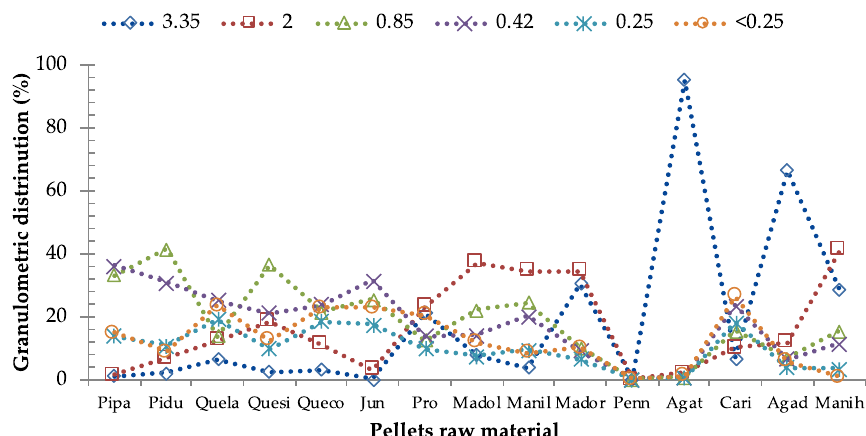
Figure 7. Granulometric distribution of ash from 15 pelletized biomass sources.